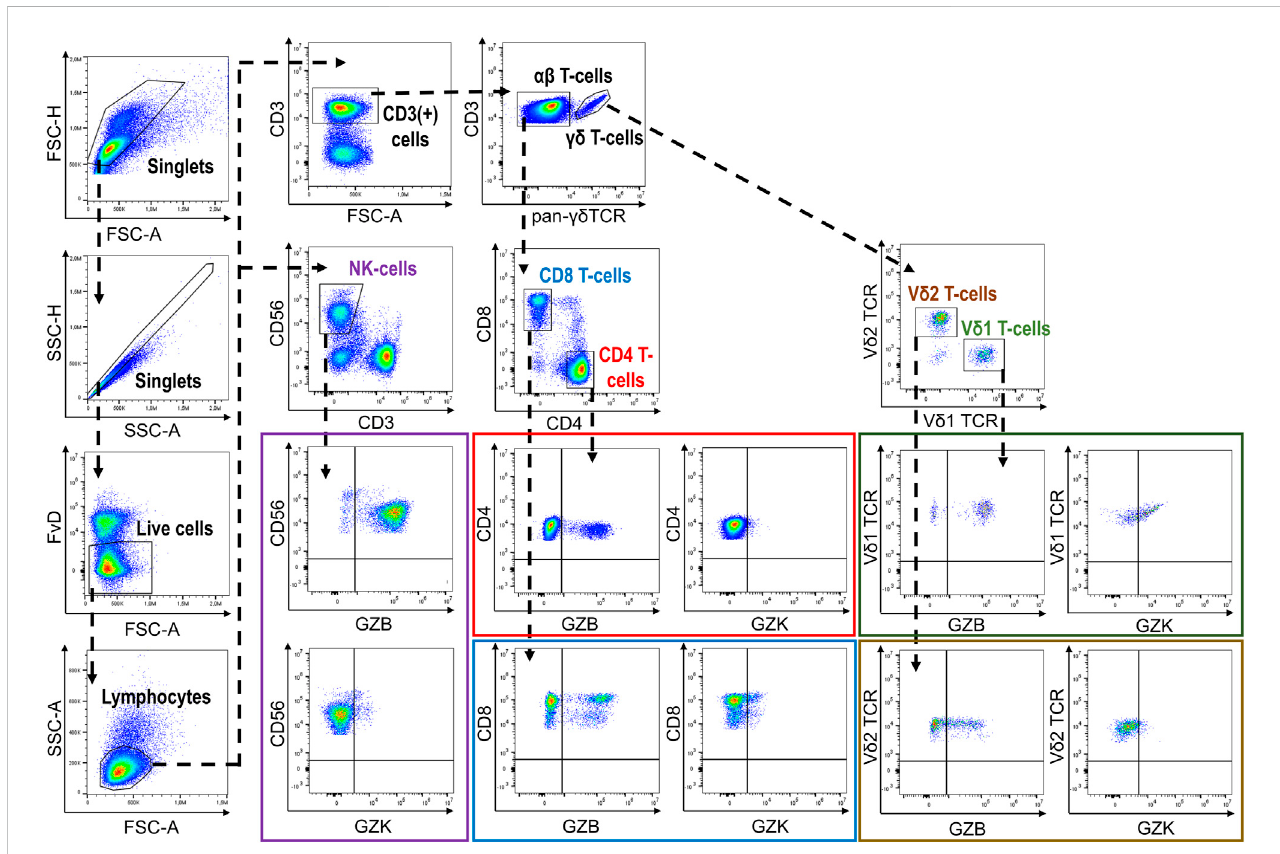
FIGURE 1 Gating strategy depicting the identi fi cation of GZB- and GZK-expressing NK-cells and CD4 + , CD8 + and γδ + T-cells.